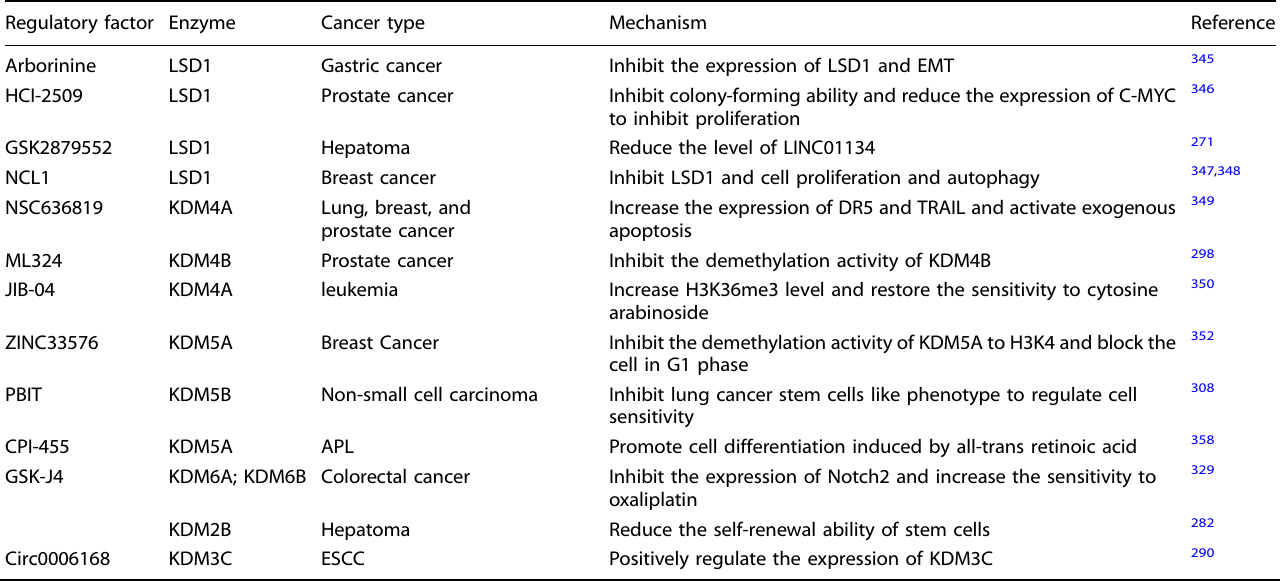
Table 4. Histone demethylase inhibitors and siRNA for overcoming drug resistance Regulatory factor Enzyme Cancer